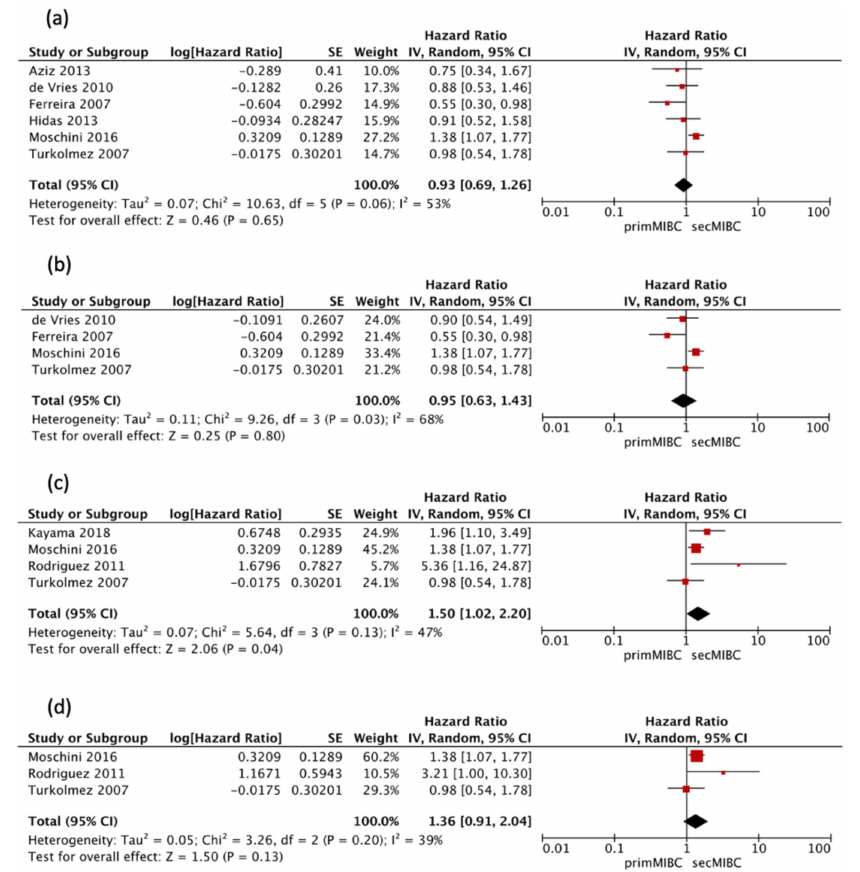
Figure 5. ( a ) Forest plot 5-year CSS including only studies utilizing second-look TURBT, ( b ) Forest plot 10-year CSS including only studies utilizing second-look TURBT, ( c ) Forest 5-year CSS including only studies utilizing NAC, ( d ) Forest plot 10-year CSS including only studies utilizing NAC.